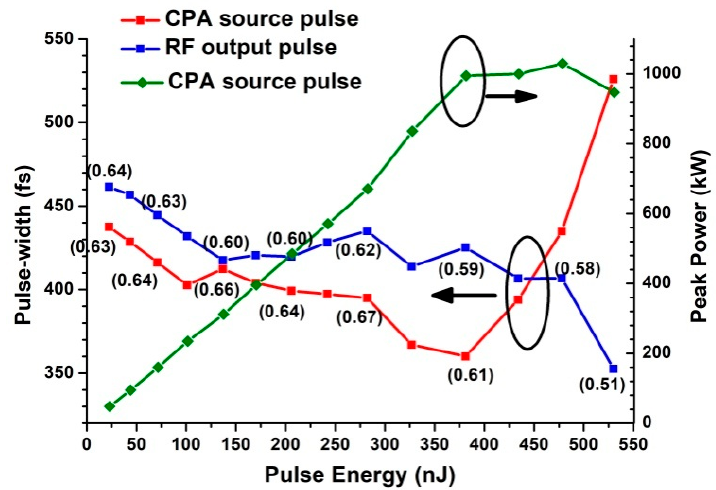
Figure 16. Chirped pulse amplification(CPA) source (red) and RF output (blue) pulse-width also with CPA source pulse peak power (green) versus CPA source pulse energy. (TBP values are given in parentheses) [35].